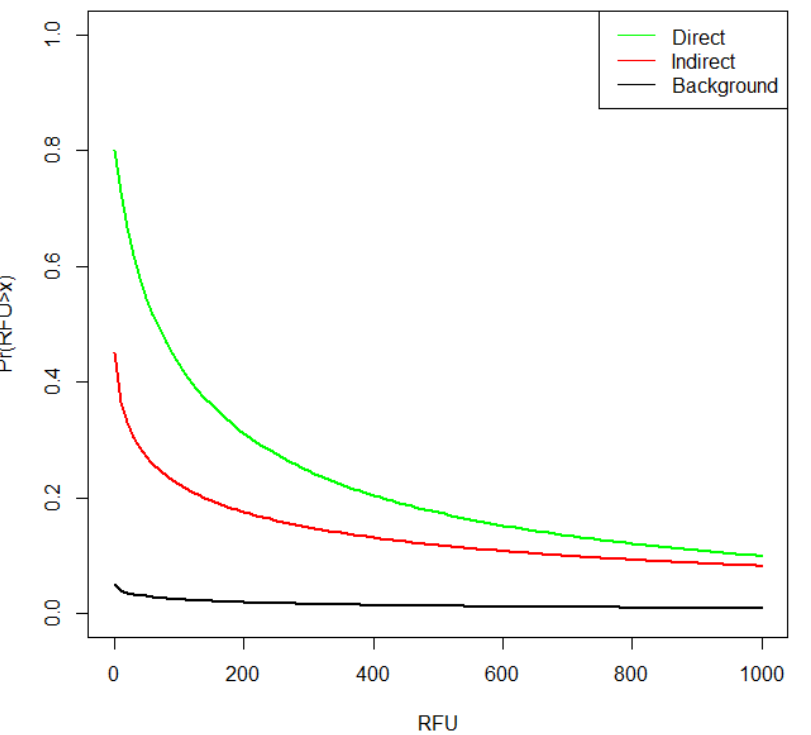
Figure 8. Comparison of probabilities of direct, indirect and background TPPR for the zip-lock drugs bag example. Direct transfer was modelled from RFU E 1 dbag ; personal bag (indirect transfer) was modelled from RFU E 2 pbag data and background was also modelled from RFU E 2 pbag data, with adjusted k = 0.95 (the proportion of observations with no background) in order to scale results as described in Supplementary Material S1. Table 3. Activity level likelihood ratios where only contributor A is recovered, with sensitivity analysis, showing 2.5–97.5 percentiles. The median (50 percentile) values are those that are reported. Results for the discrete model are shown in the top row; continuous models conditioned upon RFU A > x are shown in remaining